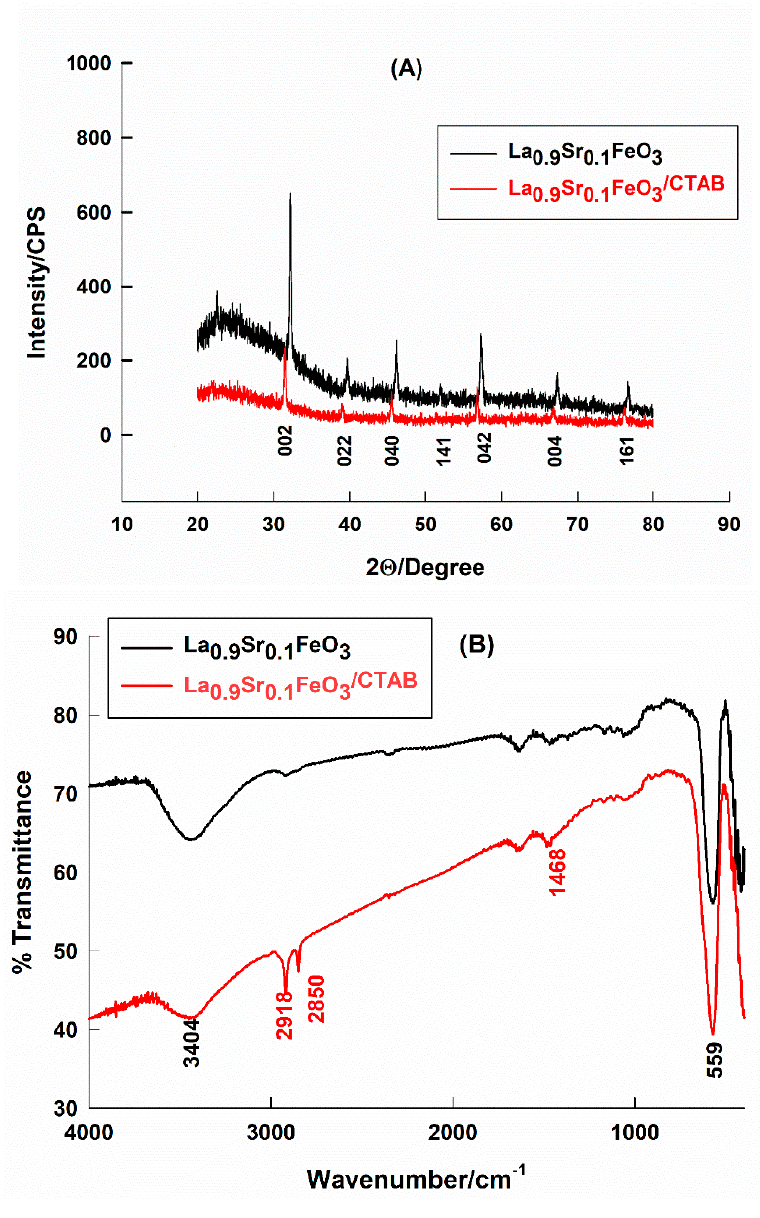
Figure 1. XRD patterns ( A ) and FTIR spectra ( B ) of pure and CTAB-capped La 0.9 Sr 0.1 FeO 3 . Corresponding Miller indices and wavenumbers are indicated.